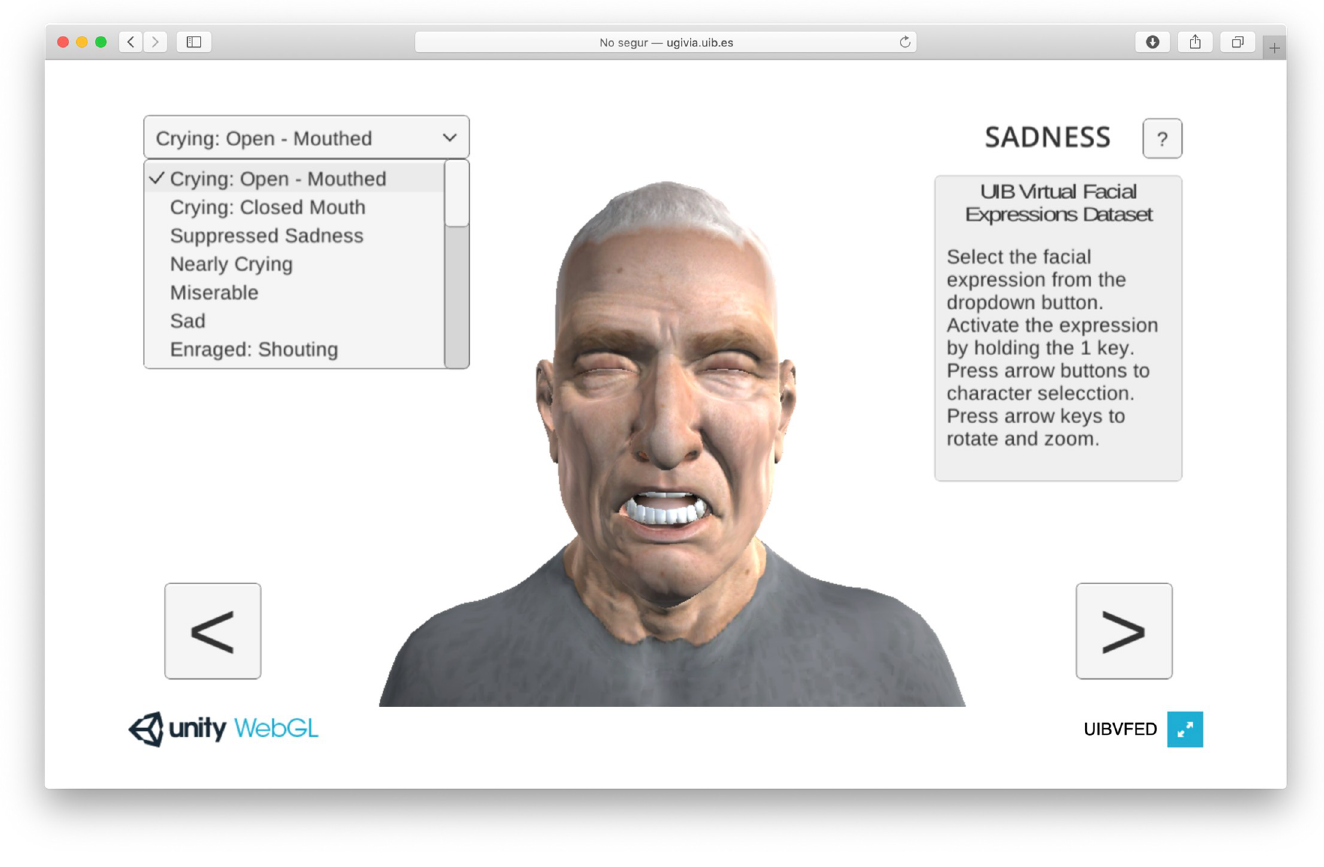
Fig 3. UIBVFED application